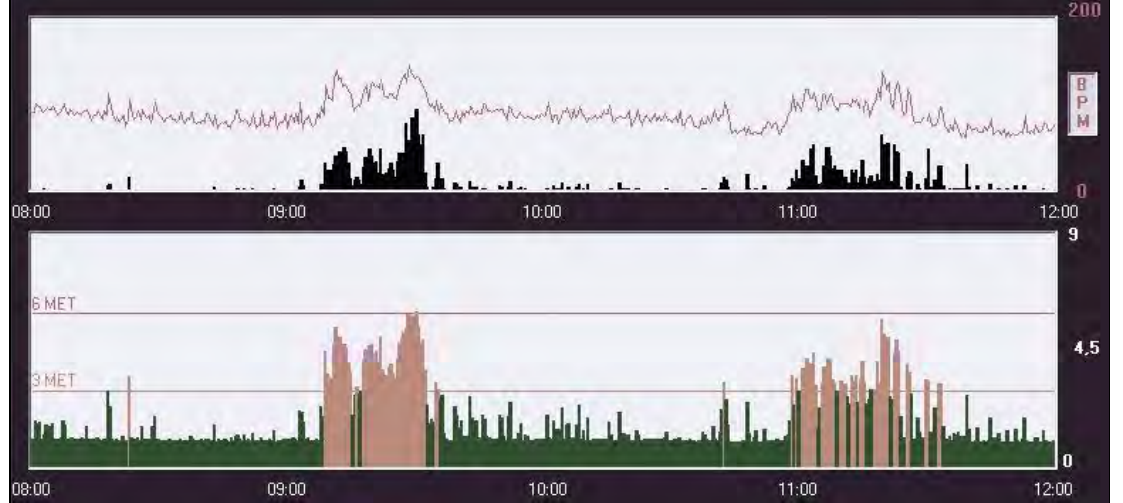
Figure 2. An average forenoon’s physical activity-diagram of an adolescent 9th grade student